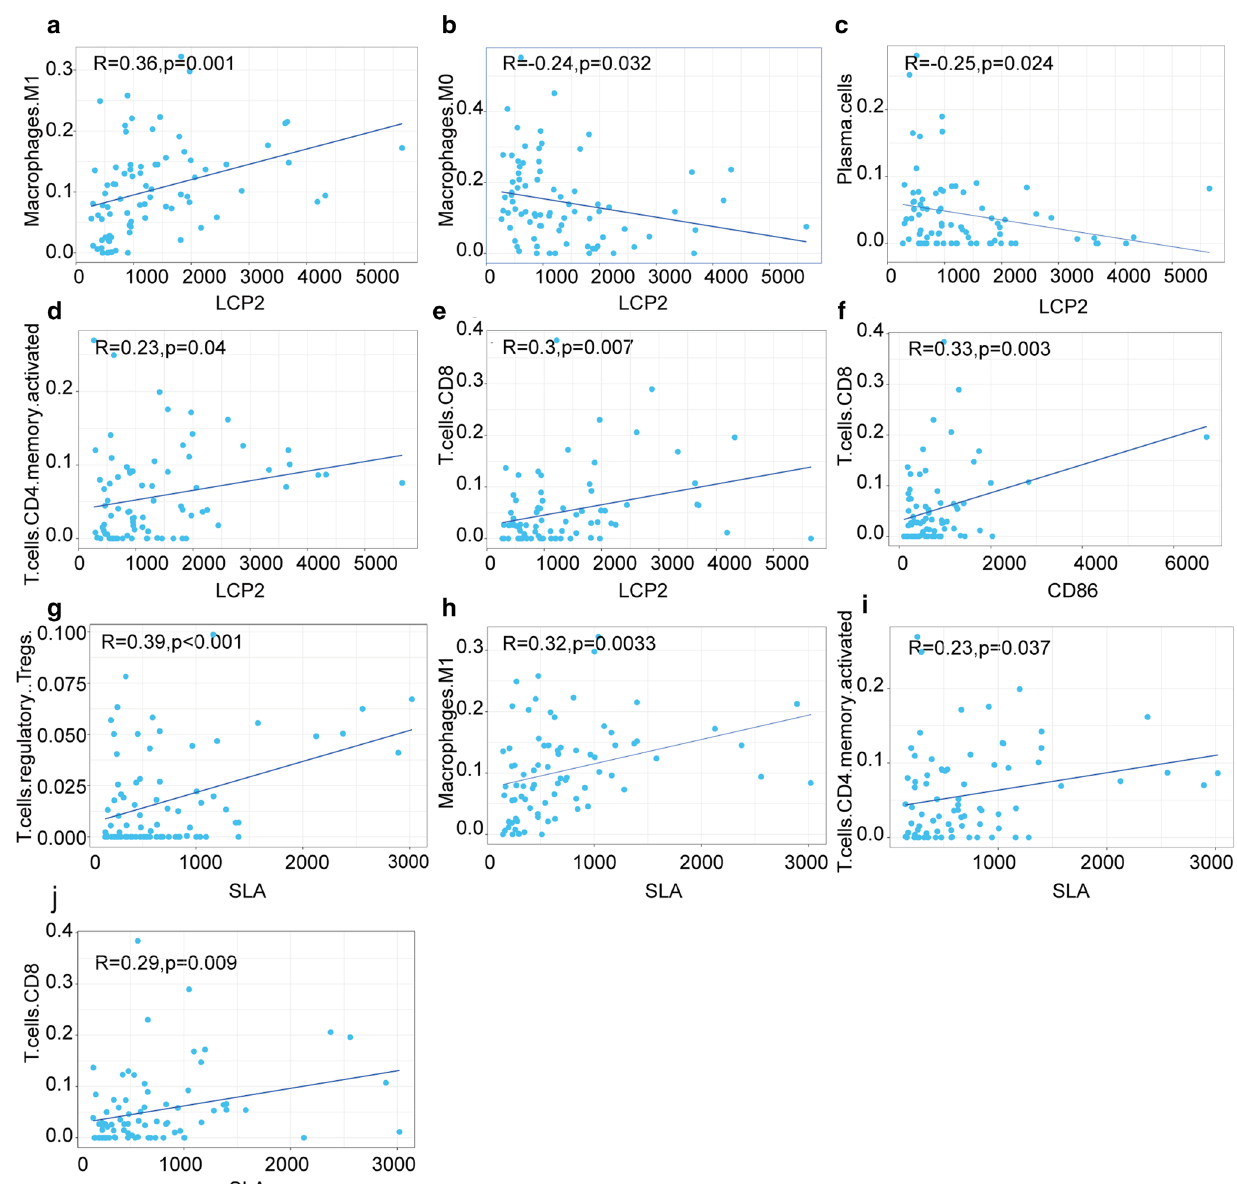
Fig. 12 Scatter plot of the correlation between TICs proportion and gene expression (p <